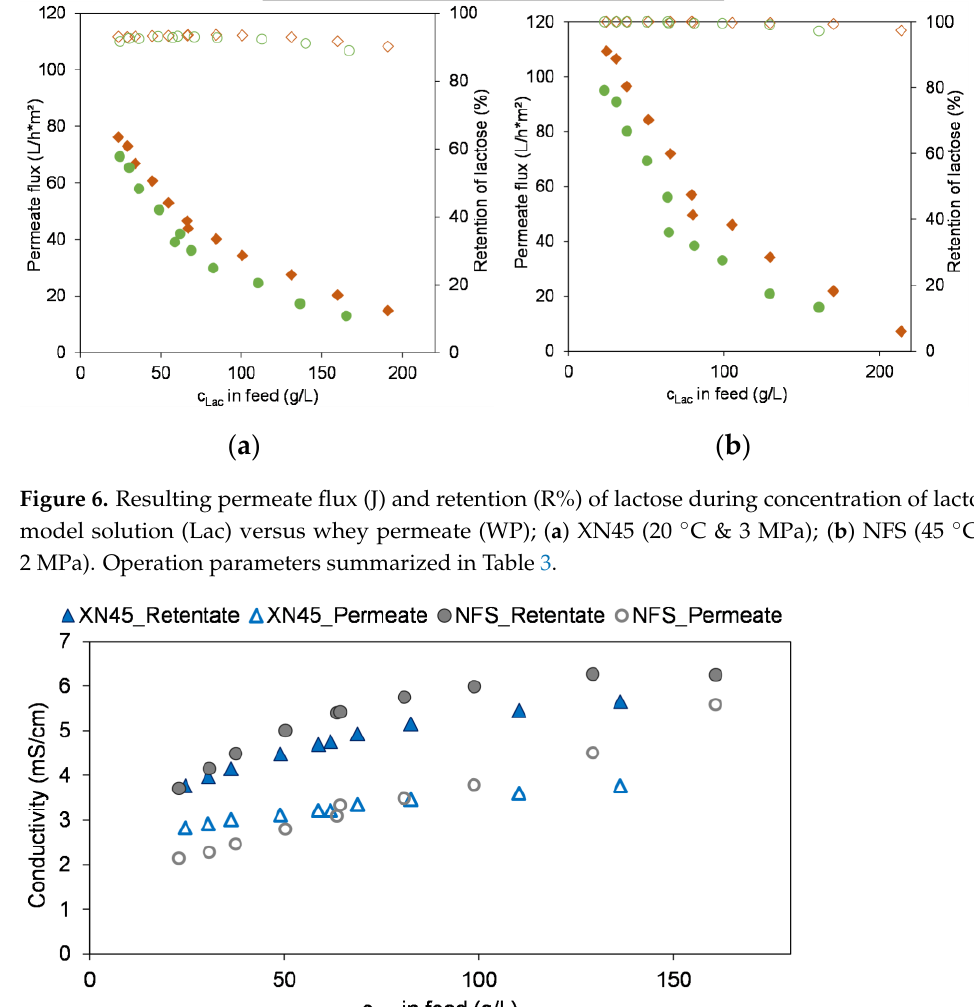
Figure 7. Comparative comparison of the course of conductivity in retentate and permeate during the concentration of lactose in whey permeate with XN45 and NFS